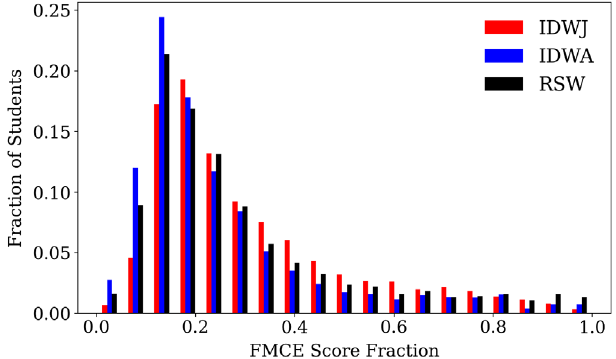
FIG. 2. The fractional score distributions on the FMCE are shown for three separate datasets: 1531 Japanese students (IDWJ) and 2347 American students (IDWA) used in Ishimoto, Daven- port, and Wittmann [30]; 6584 American students (RSW) obtained from PhysPort and other sources